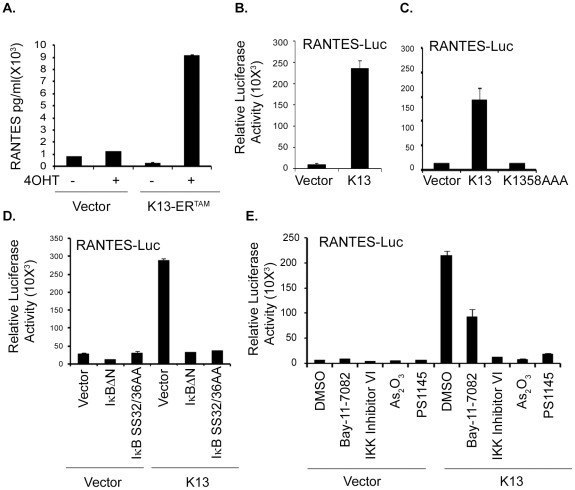
K13-induced NF-κB activity is critical for the activation of RANTES.(A) K13-induced up regulation of RANTES at protein level. Cellular supernatant from BCBL1 vector and K13-ERTAM cells treated with and without 4OHT were collected and used to measure the secretion of RANTES by ELISA. The values shown are averages (mean ± SE) of one representative experiment out of three in which the level of RANTES secretion was measured in triplicate. (B–C) 293T cells were transfected with an empty vector, wild-type K13 (B) or K13-58AAA (C) (250 ng/well) along with a RANTES promoter-driven luciferase constructs (75 ng/well) and a pRSV/LacZ (β-galactosidase) reporter construct (75 ng/well), and the reporter assay performed as described under the Materials and Methods section. (D) Dominant-negative mutants of IκBα (IκBαΔN and IκBαSS32/36AA) block K13-induced RANTES promoter activity. 293T cells were transfected either with the indicated plasmids and reporter assay performed as described above. The amount of IκBα mutant plasmids (500 ng/well) was five times the amount of vector or K13 (100 ng/well) plasmid and the total amount of transfected DNA was kept constant by adding empty vector. (E) Pharmacologic inhibitors of NF-κB block K13-induced RANTES promoter activation. 293T cells were transfected with an empty vector or a vector encoding K13 along with RANTES-Luc and pRSV/LacZ reporter constructs. Approximately 3 hours after transfection, cells were treated with dimethyl sulfoxide (vehicle) or the indicated compounds for 18 hours before cell lysis and measurement of reporter activities. Reporter assay was performed as described for Figure 4B–C.